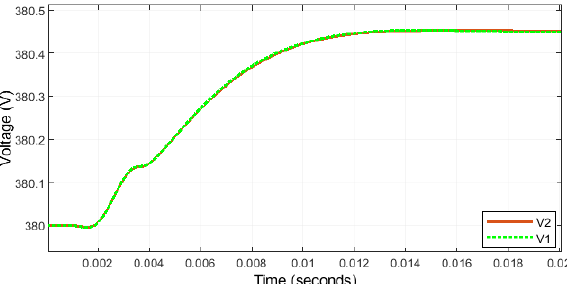
Figure 4. Voltage changes after the parallel connection of inverter V DGi = V1 ( i = 1,2 ) .